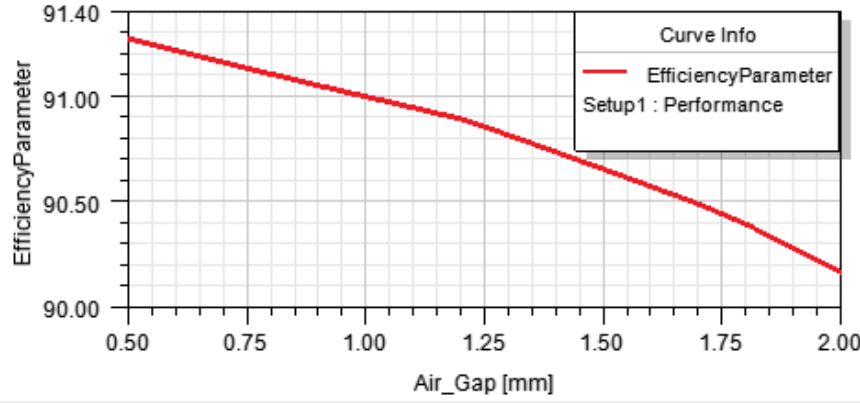
Figure 10. Motor efficiency for the different air gap